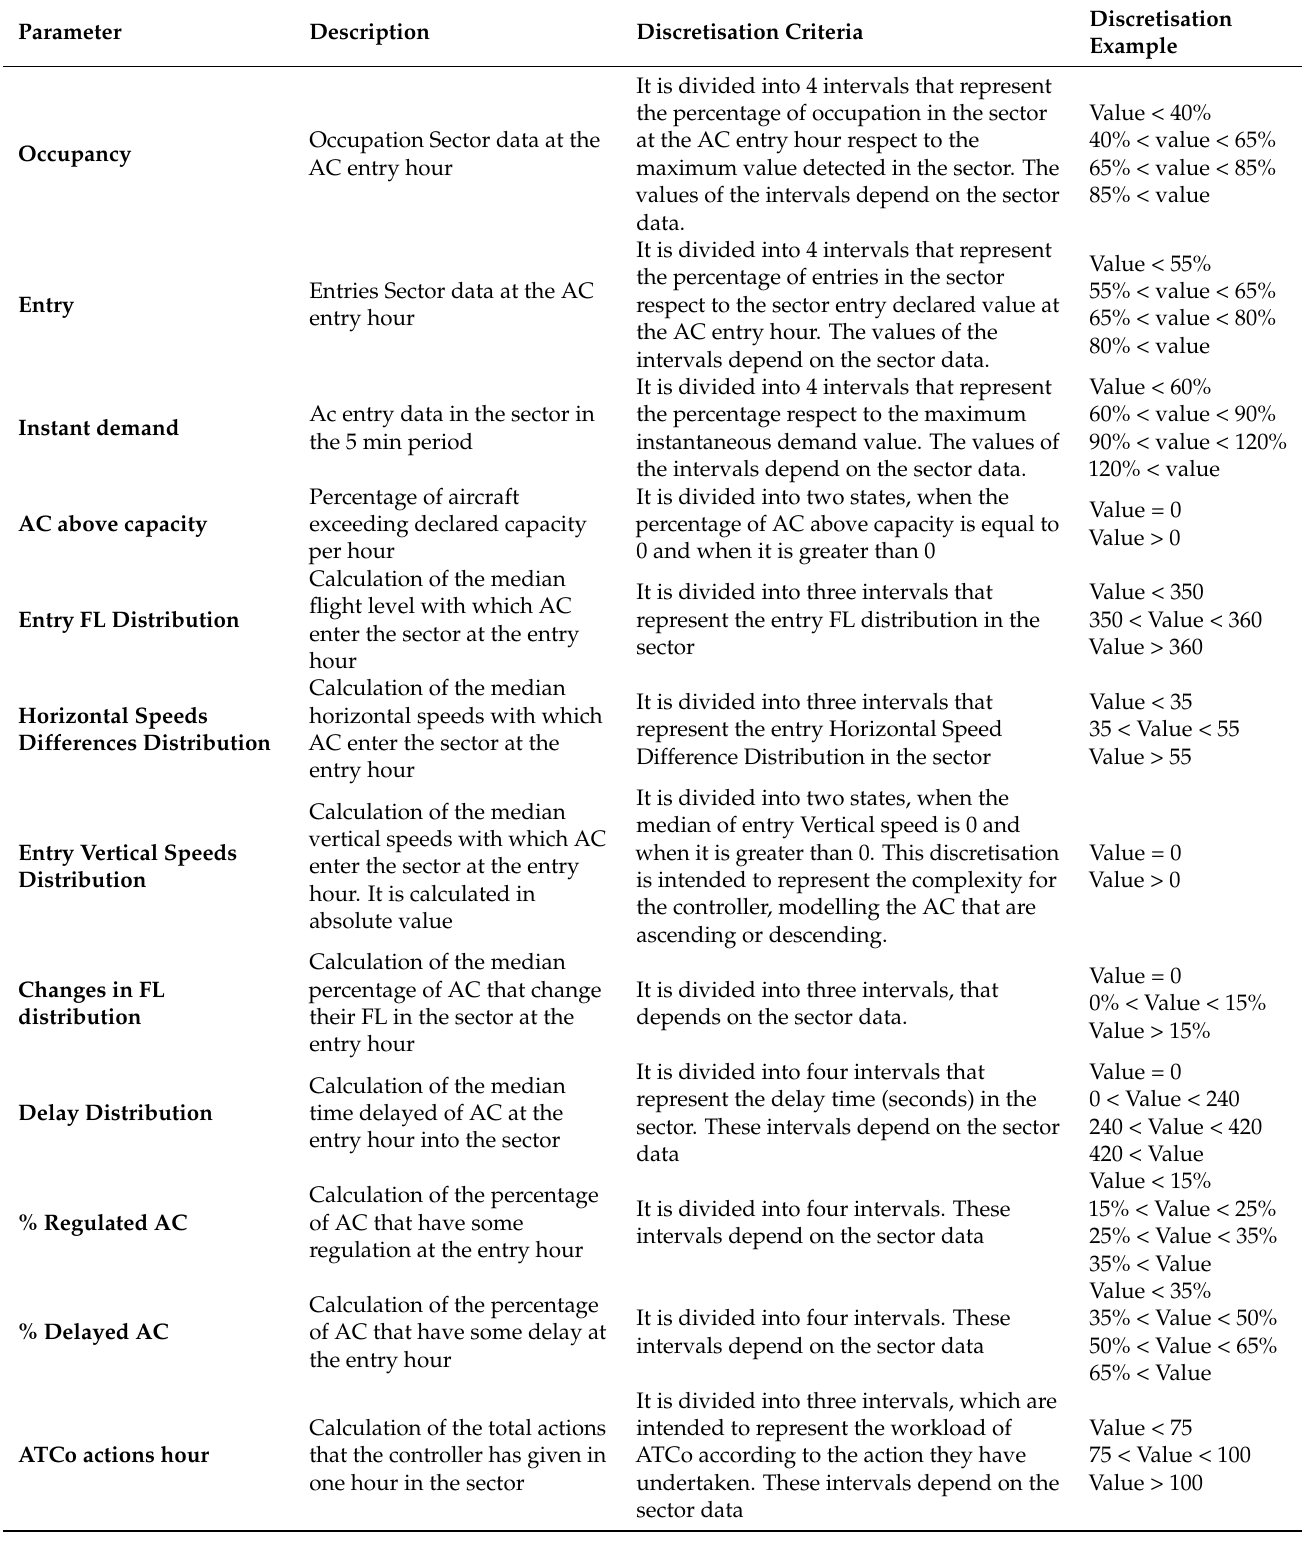
Table 1. Model variables, description and discretisation